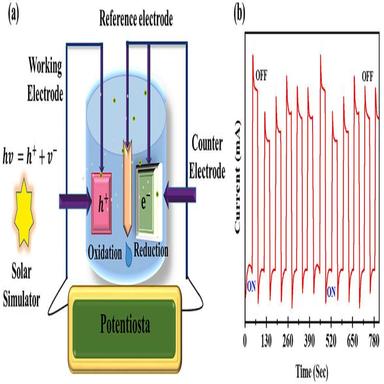
(a) Schematic representation of the fundamental workings of a photoelectrochemical cell. (b) Photocurrent-time profile for the CNT@CoMgS photoelectrode in a chopped light (On/Off) conditions.